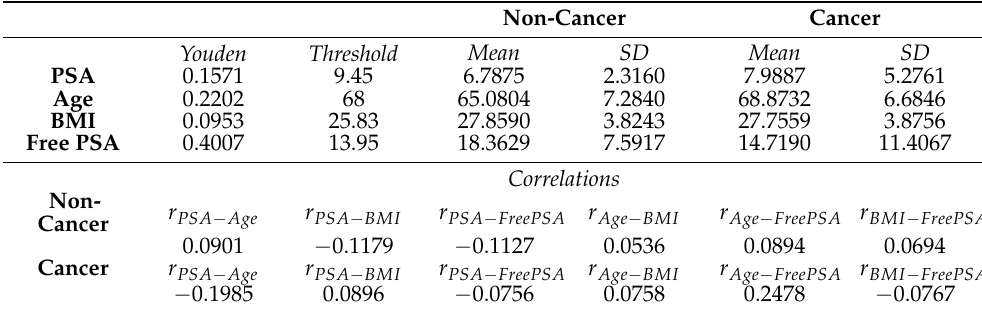
Table 19. Prostate cancer dataset information.